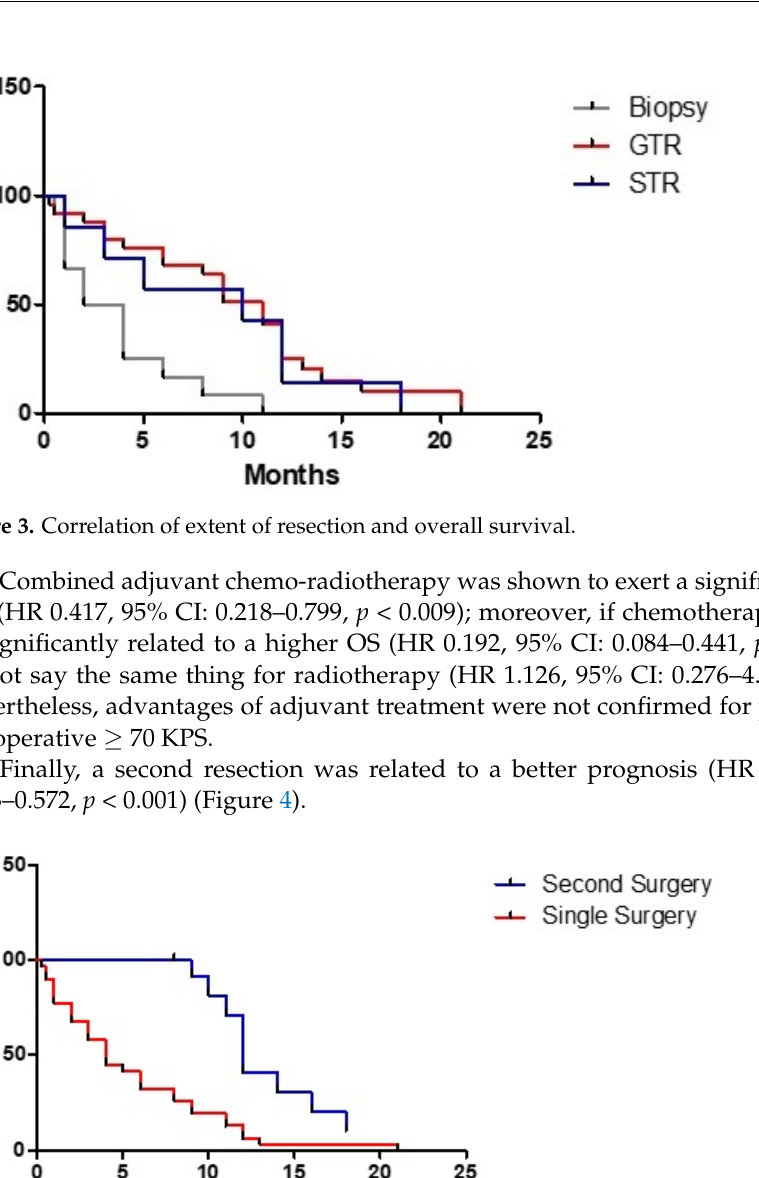
Figure 2. Role of postoperative KPS on overall survival.